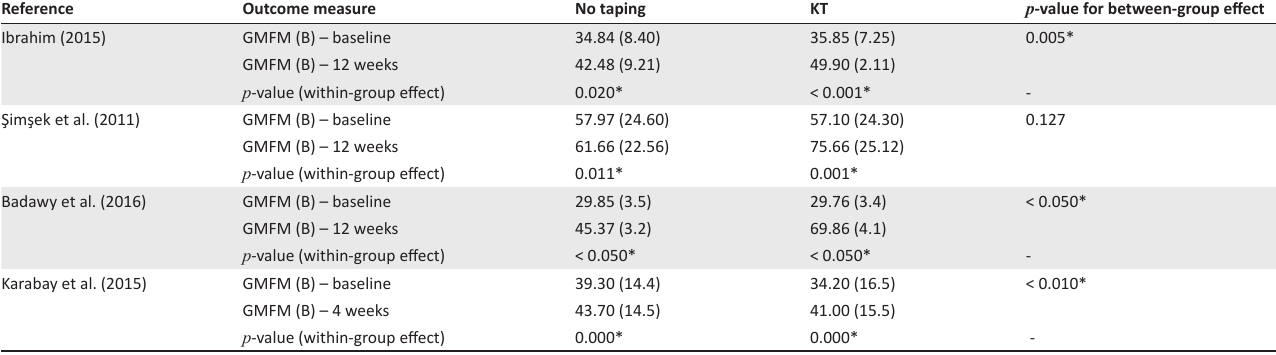
TABLE 5: Effect of kinesiology taping on gross motor function as determined by the Gross Motor Function Measure (B).